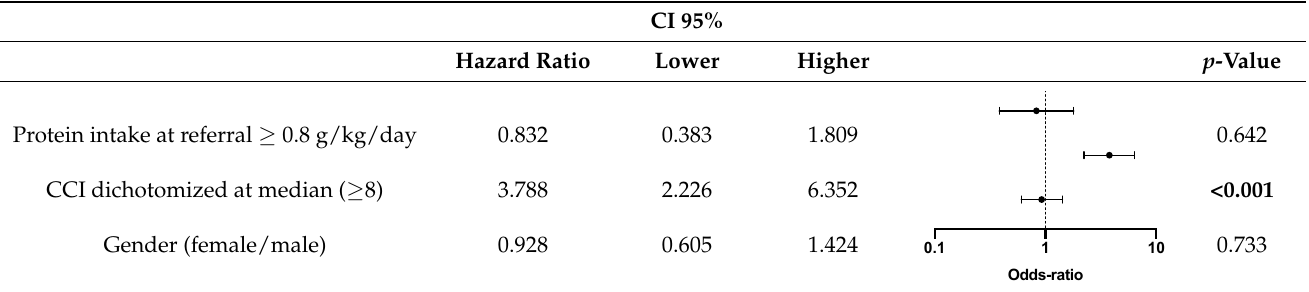
Table 4. Cox regression analysis of survival according to baseline diet and CCI.